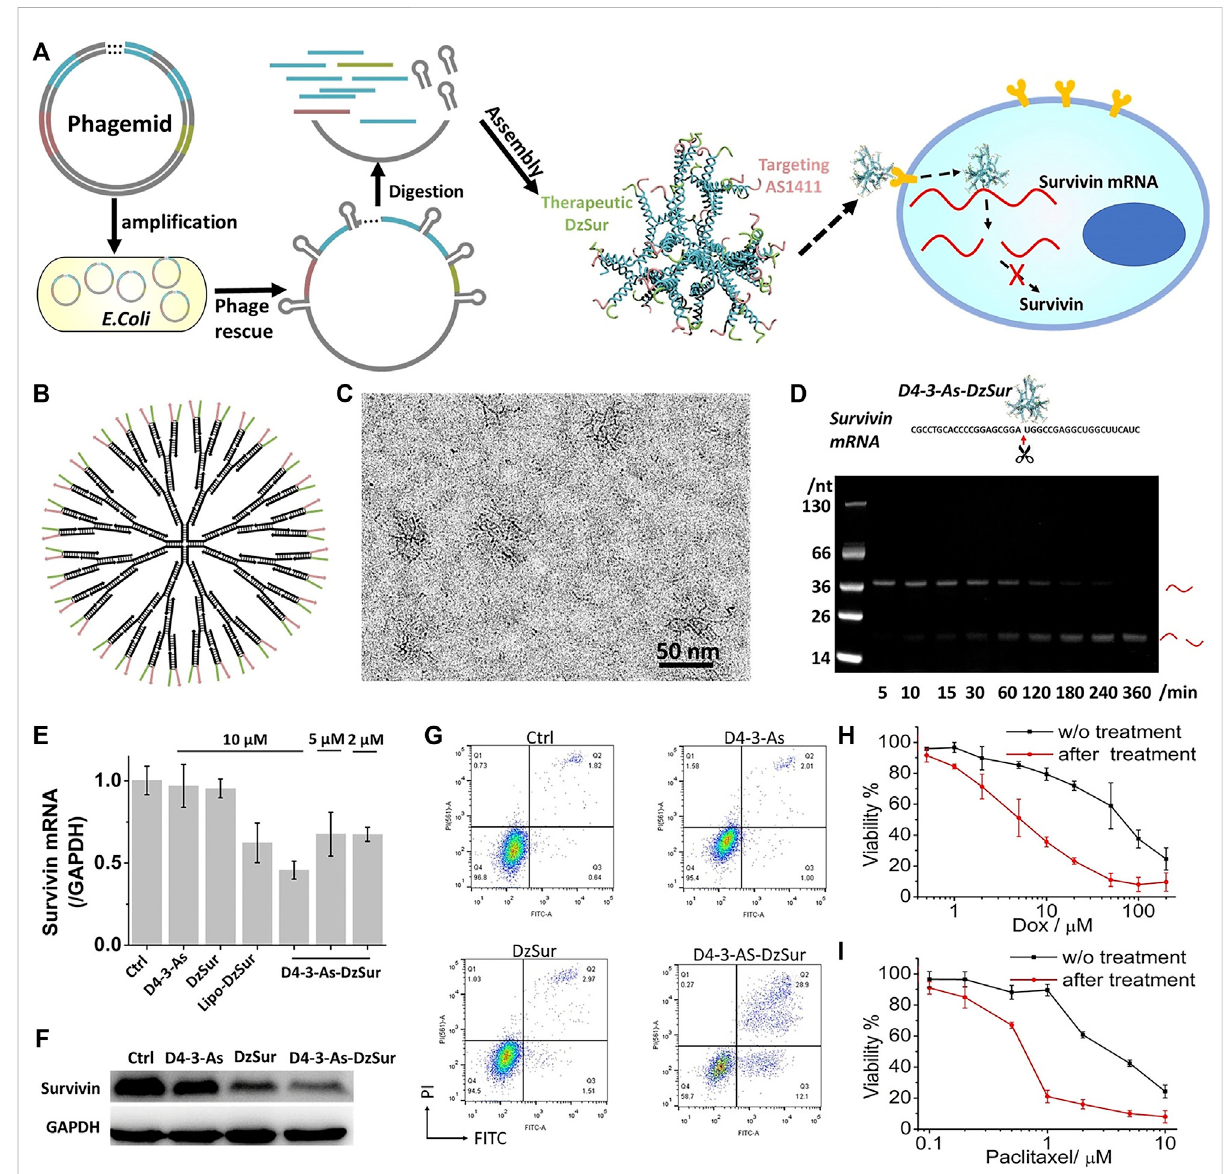
FIGURE 5 Targeted survivin regulation by the DNA-dendrimer-based nanomedicine D4 ‒ 3-As-DzSur. (A) Biotechnological production. (B) 2D structure. (C) Cryo-TEM image. (D) Survivin mRNA cleavage property. (E) qPCR tests. (F) Western blot analysis of survivin suppression in A549 cells. (G) Apoptosis analysis of A549 cell. (H,I) Chemosensitization effect on DOX (H) and paclitaxel (I) . (Lu et al.,